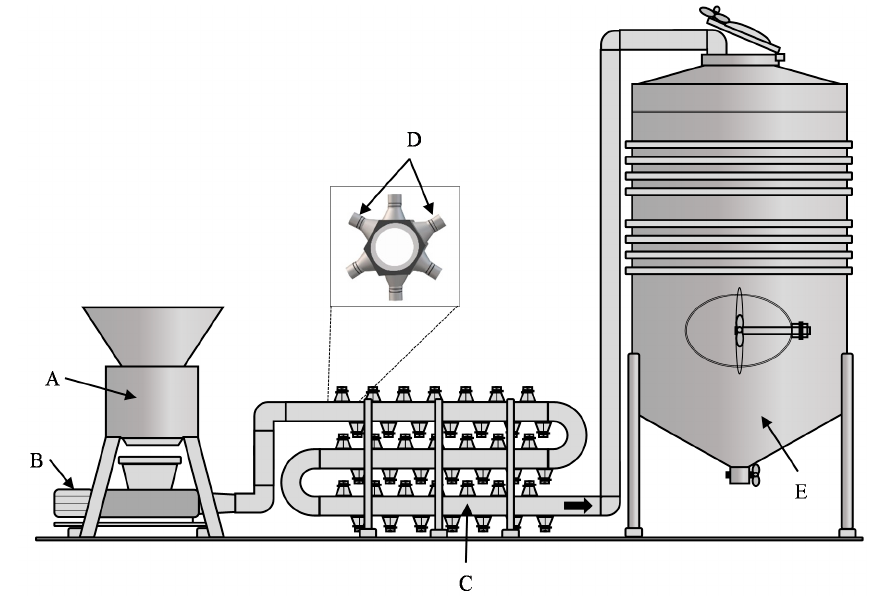
Figure 2. Flow chart of grape processing with ultrasound technology. ( A ) destemming; ( B ) progressive cavity pump; ( C ) ultrasound treatment zone; ( D ) transducer; ( E ) fermentation tank.